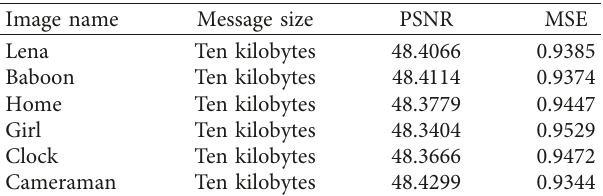
Table 6: Performance analysis of the proposed method using (256 ∗ 256) images.